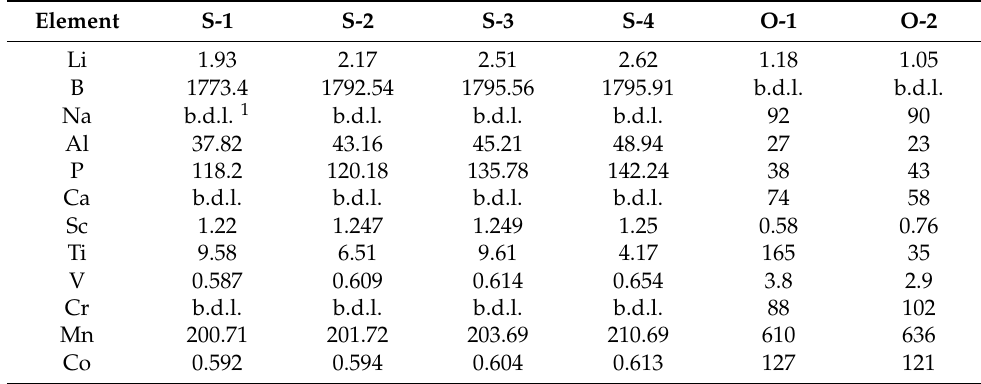
Figure 2. The B concentration of forsterite from the Jian forsterite jade compared with olivine from other origins. Table 2. Trace element composition (ppm) of B-rich